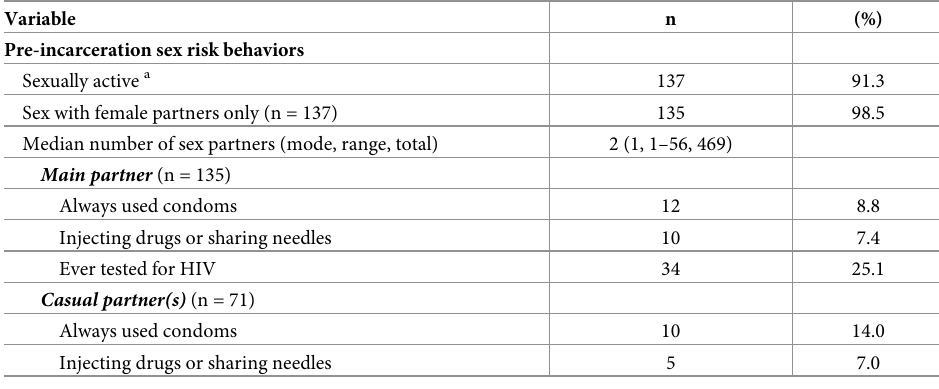
Table 2. Pre-incarceration HIV risk behaviors among HIV-infected male prisoners (n = 150).